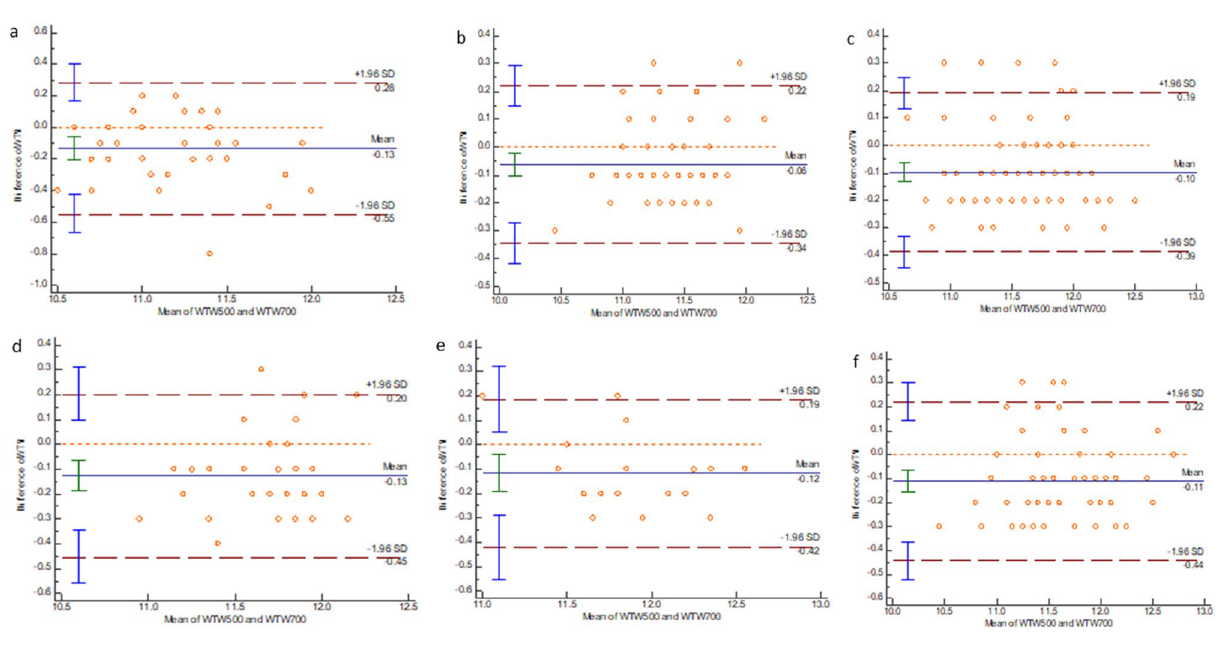
Figure 4. Bland–Altman plot showing the results of WTW measurement by the two instruments. ( a ) AL < 22.00 mm group. ( b ) 22.00 mm ≤ AL < 23.00 mm group. ( c ) 23.00 mm ≤ AL < 24.00 mm group. ( d